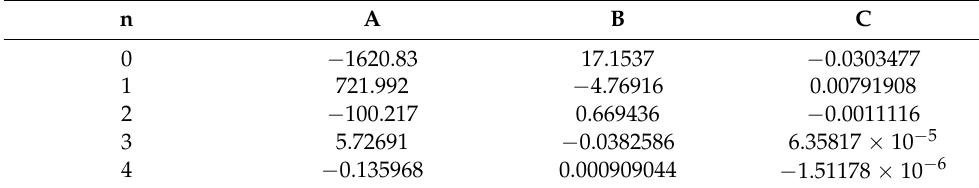
Table A39. Coefficients of the CH 3 OH-LiBr density equation.